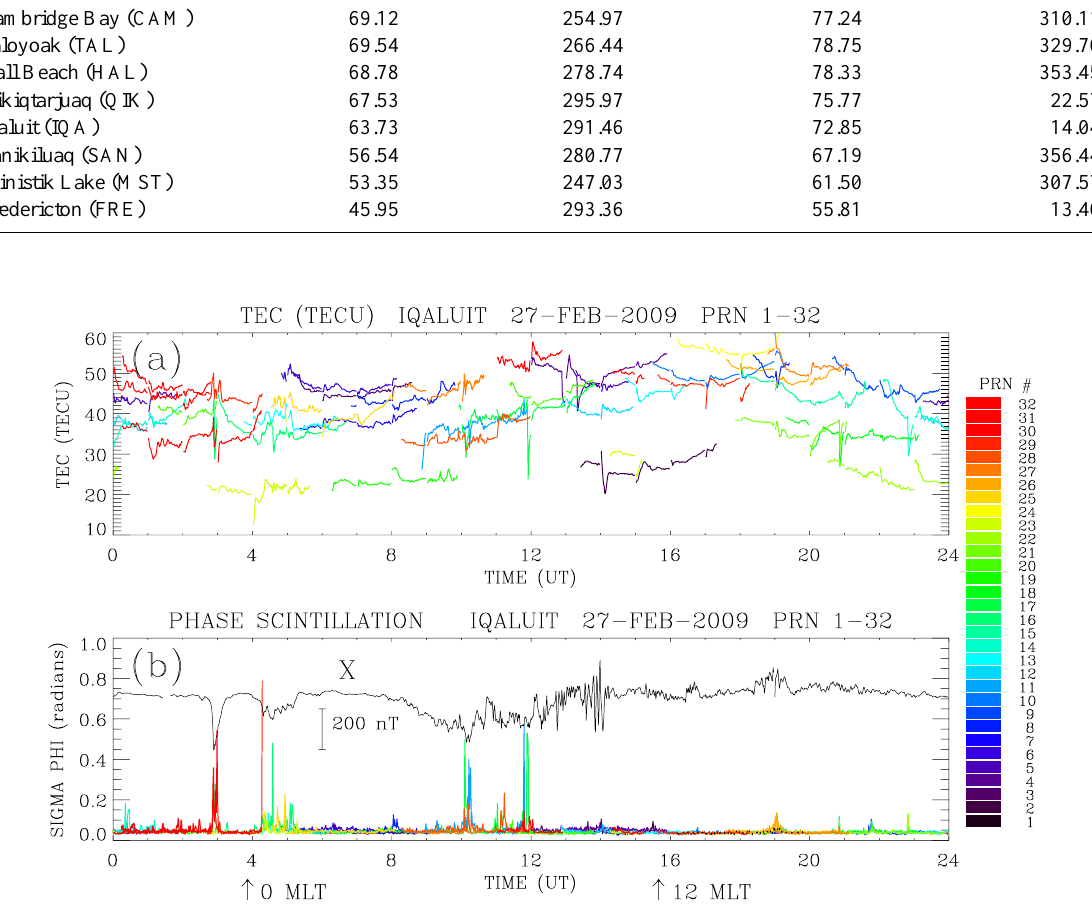
Fig. 2. (a) TEC and (b) phase scintillation index σ 8 observed at elevations above 30 ◦ from Iqaluit. The ground magnetic field X-component is